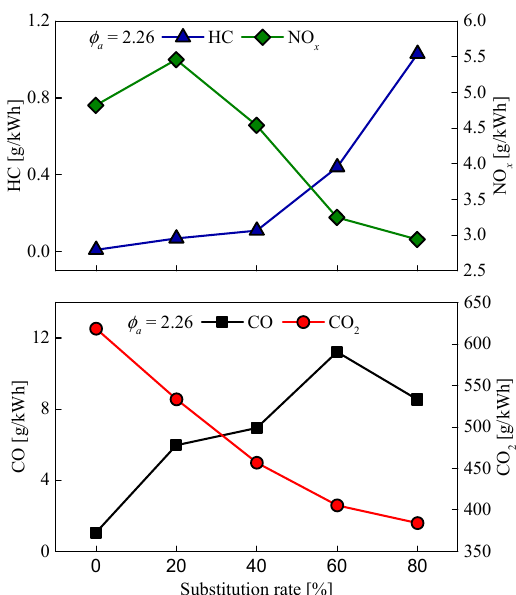
Figure 9. Comparison of emissions level with different substitution rates at 1600 rpm, 50.6 N·m.